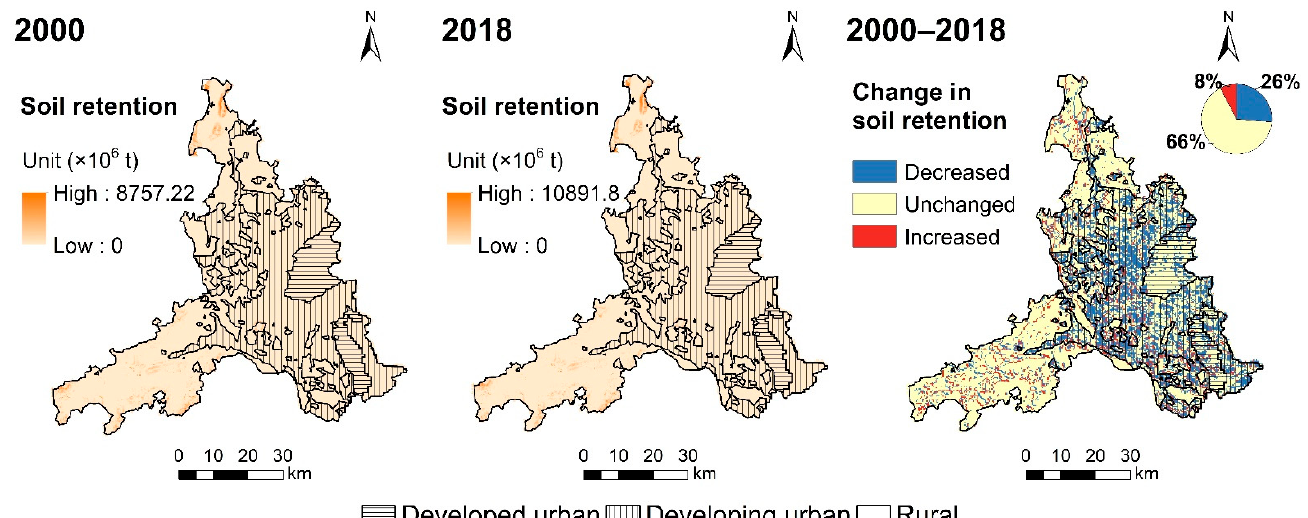
Figure 10. Spatial patterns of soil retention in Foshan from 2000 to 2018.